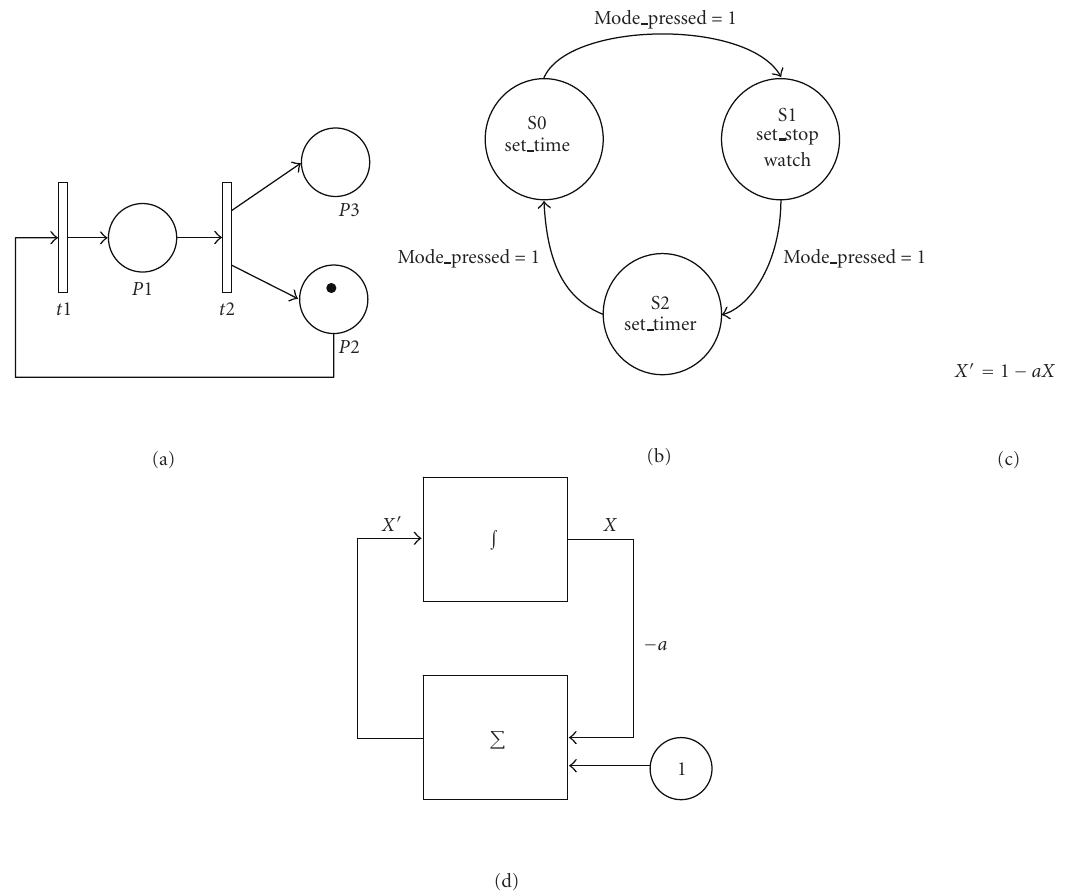
Figure 1: Four types of dynamic system models. (a) Petri net. (b) Finite state machine. (c) Ordinary di ff erential equation. (d) Functional block